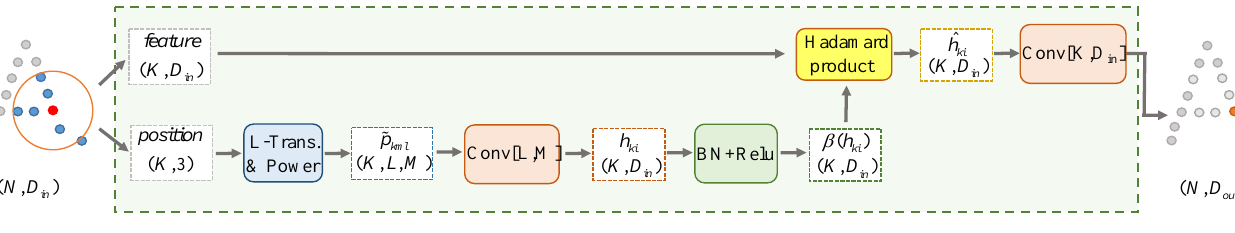
Figure 3. Pipeline of our separable PSConv. L-Trans. and Power denote the linear transform and power operation, which are described in Equations (1) and (2). Refer to Section 3.2 for the details of this separable